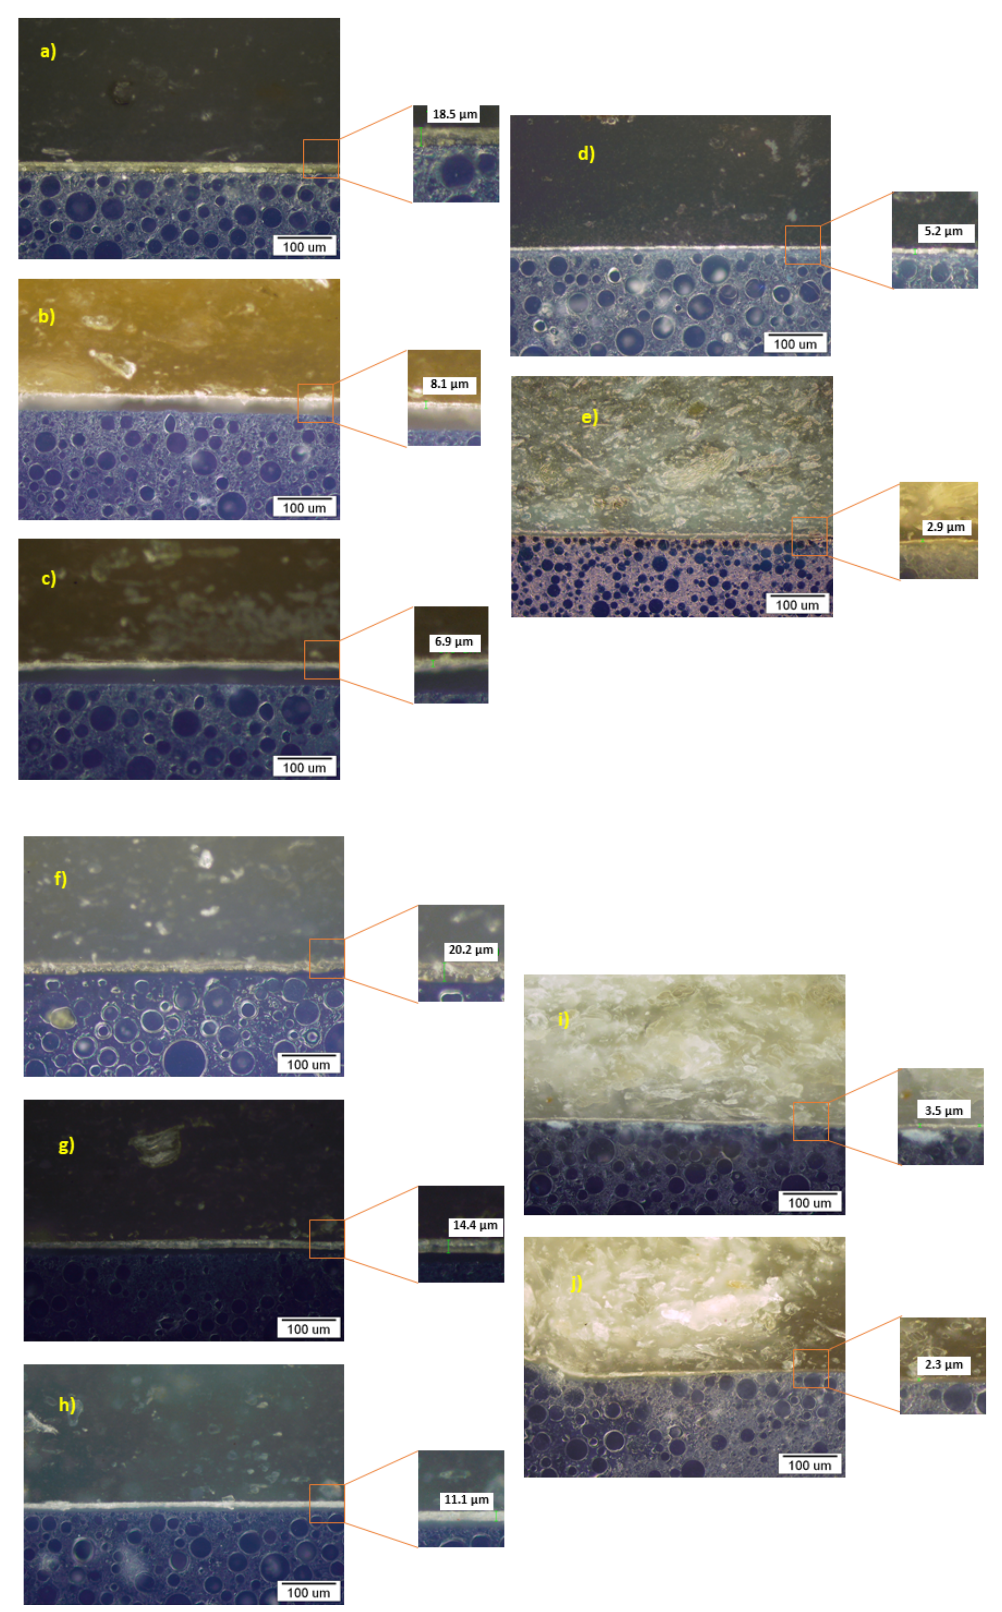
Figure 9. Micrographs of the boundary surfaces of the samples: WF-PP-5 ( a ), WF-PP-10 ( b ), WF-PP-20 ( c ), WF-PP-30 ( d ), WF-PP-40 ( e ) and WF-R-PP-5 ( f ), WF-R-PP-10 ( g ), R-WF-R-PP-20 ( h ), WF-R-PP-30 ( i ) and WF-R-PP-40 ( j ); cross section, polished state, optical microscope, dark field.